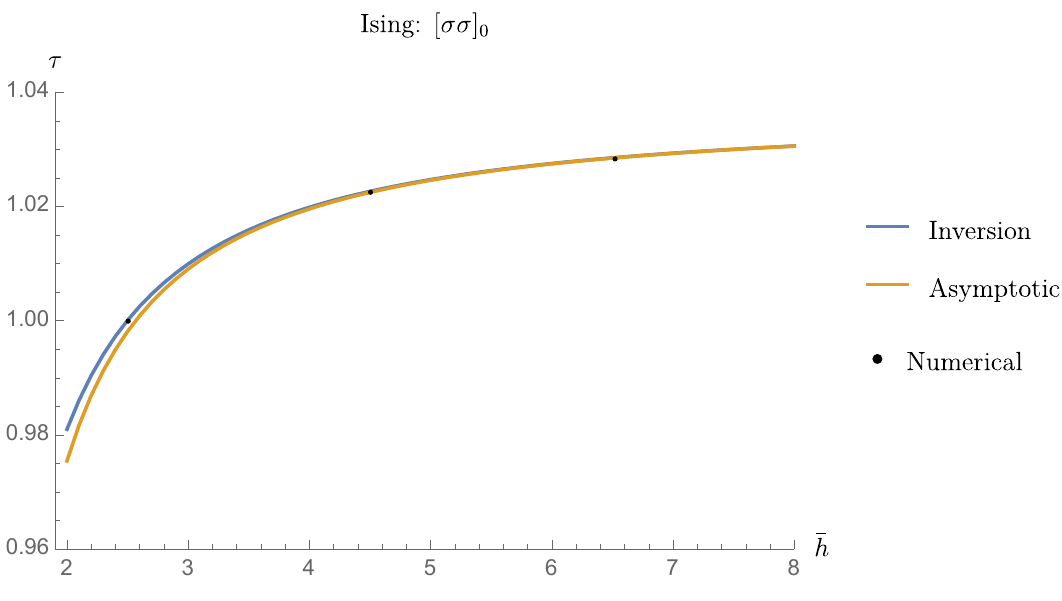
Figure 1 . Spectrum for [ σσ ] in the Ising CFT derived using the inversion formula, asymptotic 0 lightcone expansion, and numerical bootstrap. Numerical data is taken from [14]. The curves in this and later plots are obtained by matching at z = .